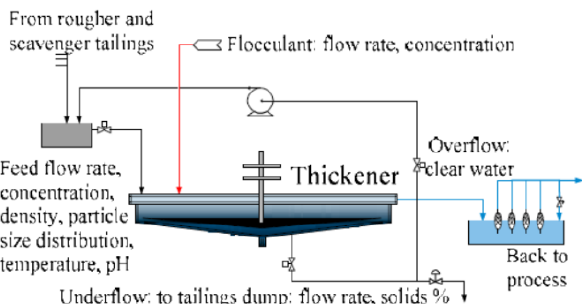
Figure 1: A typical thickener used in mineral processing [7]